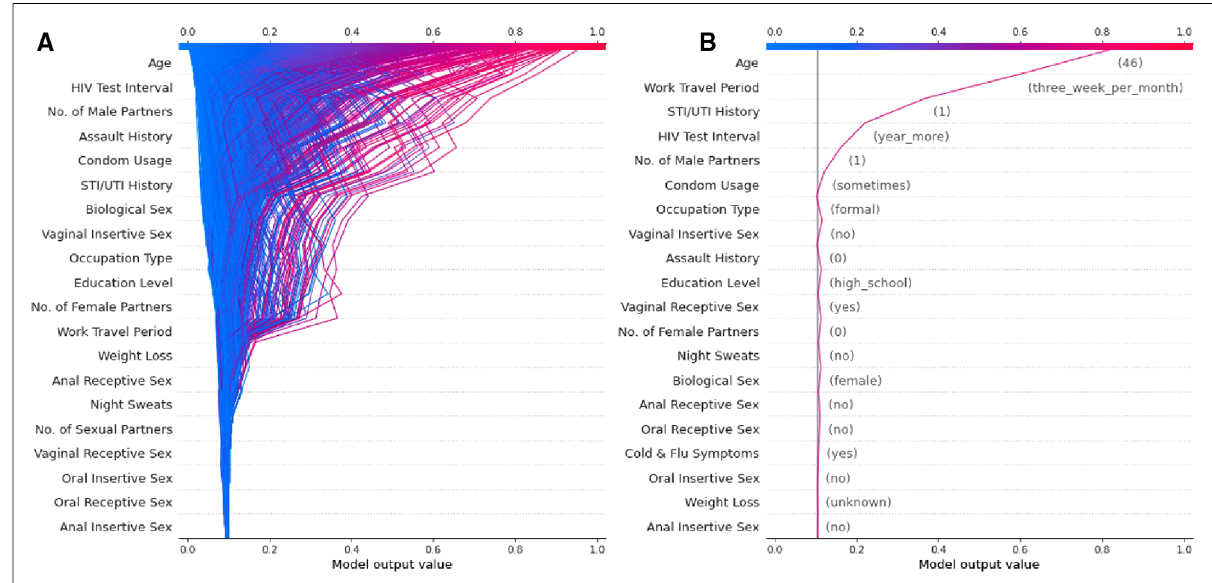
FIGURE 2 Examples of a SHAP-based feature explanation for a ML model showing (A) overall model risk output for all individuals in the test dataset and (B) an example individual at high risk for contracting